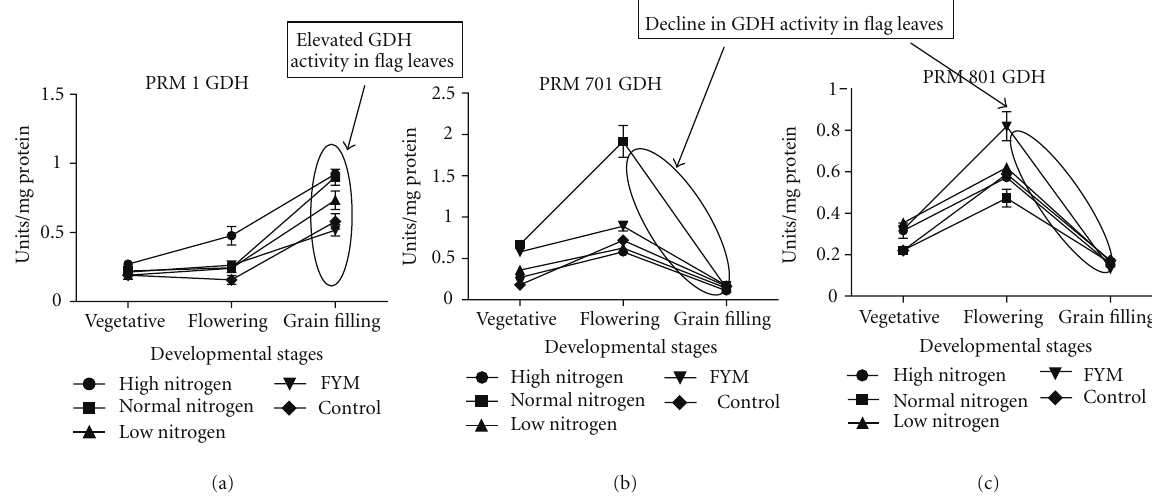
Figure 5: Influence of nitrogen fertilization on glutamate dehydrogenase (GDH) activity (specific activity) at various developmental stages of finger millet genotypes (a) brown PRM-1, (b) golden PRM-701, (c) white